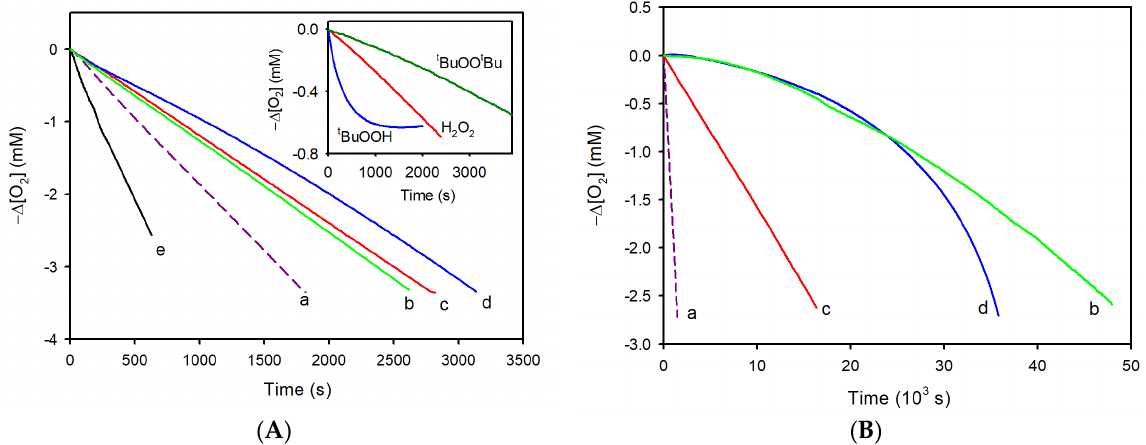
Figure 4. Oxygen consumption measured during the autoxidation of styrene (4.3 M) in MeCN, initiated by AIBN (25 mM) at 30 °C, in the absence of inhibitors (a, dashed line) or in the presence of the investigated antioxidants: Panel ( A ): MAG-NDGA (b), MAG-GA (c), MAG-TX (d), bare MAG (e), (all 0.25 mg/mL); Panel ( B ): NDGA (0.082 mM) (b), GA (0.18 mM) (c), TX (0.065 mM) (d), corresponding to the phenol concentration of the experiments reported in Panel ( A ). Inset in Panel ( A ) reports the O 2 consumption during the autoxidation of styrene (4.3 M) in MeCN in the presence of MAG (0.25 mg/mL) and 10 mM of different peroxides.